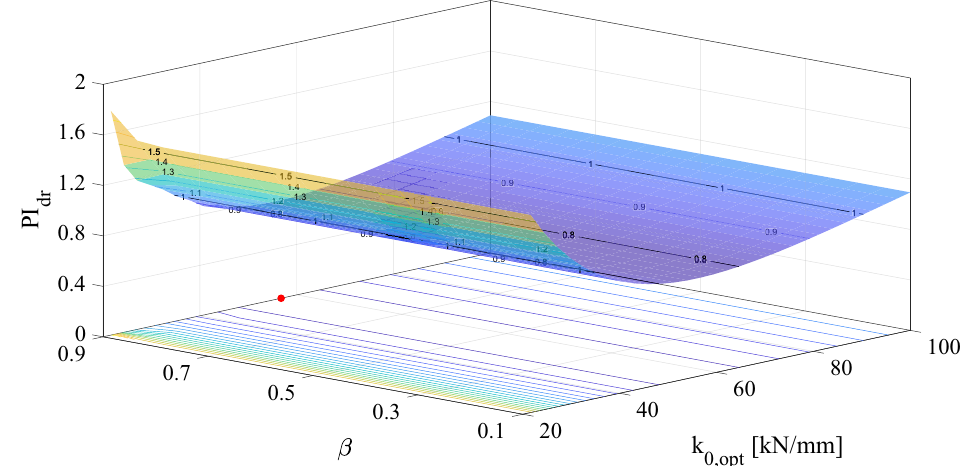
Figure 8. Optimal surface for the linearized CMS.